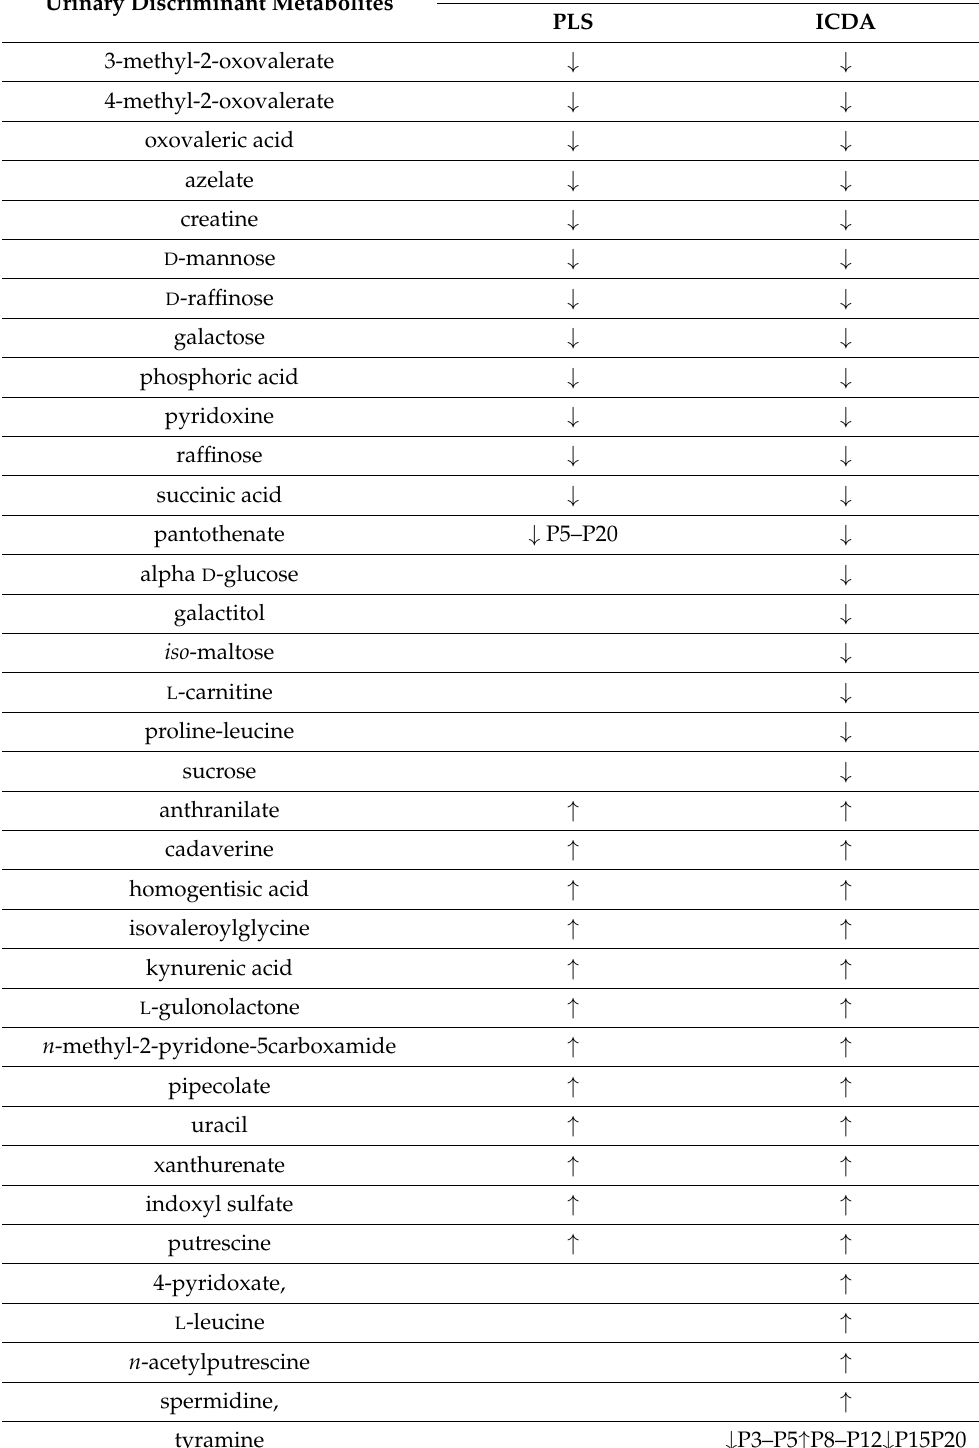
Table 2. Discriminant urinary metabolites obtained with PLS and ICDA. Data are presented as changes from P3 to P20: ↑ represents an increase and ↓ a decrease. When the changes were not linear among the protein levels, the details are indicated. When no sign was written, the metabolite was not discriminant. For more details, see Figures S1 and